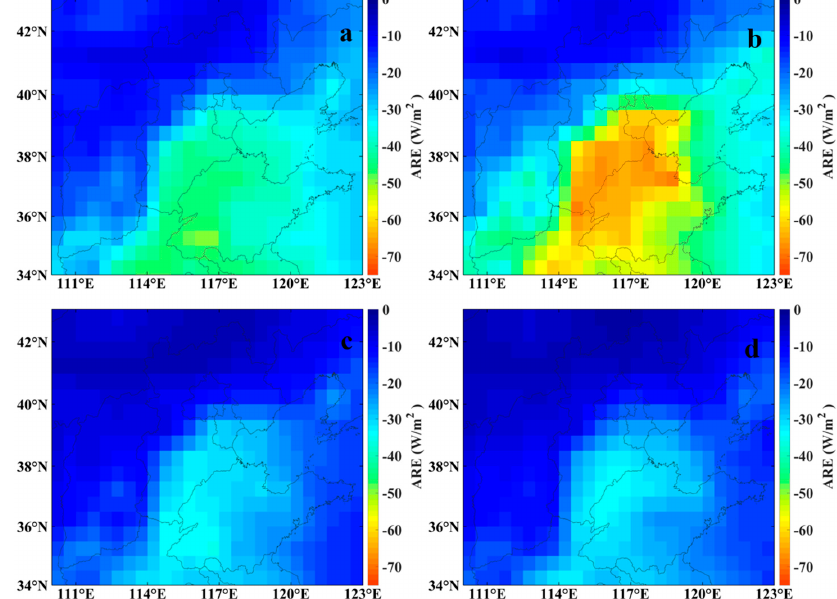
Figure 7. Spatial distribution of seasonal mean ARE in northern China from 2001 to 2015: ( a ) Spring, ( b ) Summer, ( c ) Autumn, and ( d ) Winter. Remote Sens. 2020 , 12 , x FOR PEER REVIEW